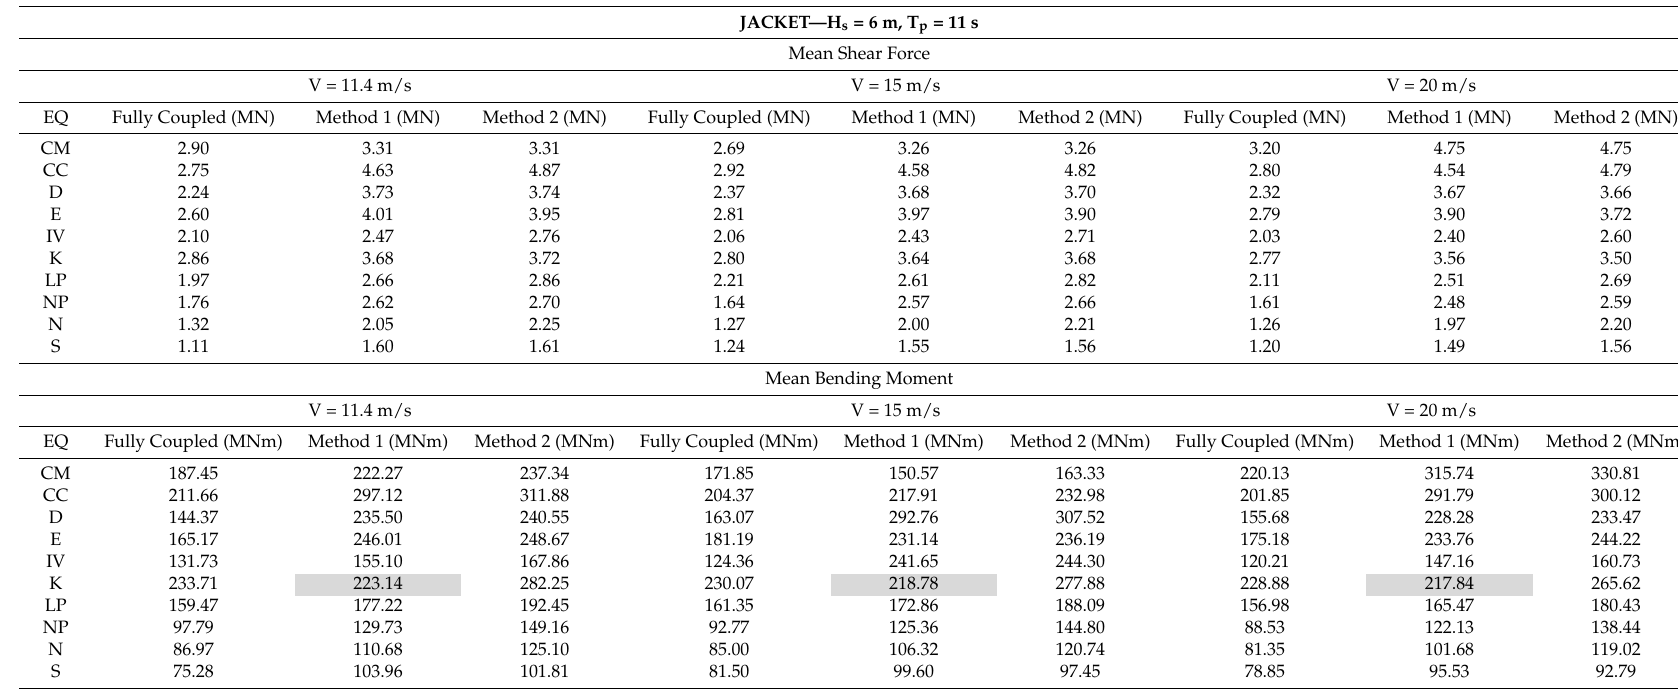
Table 5. Jacket: Mean shear-force and bending-moment demands at tower base, obtained by Methods 1-2 for sea state parameters H s = 6 m, T p = 11 s, all wind velocities and earthquake records listed in Table